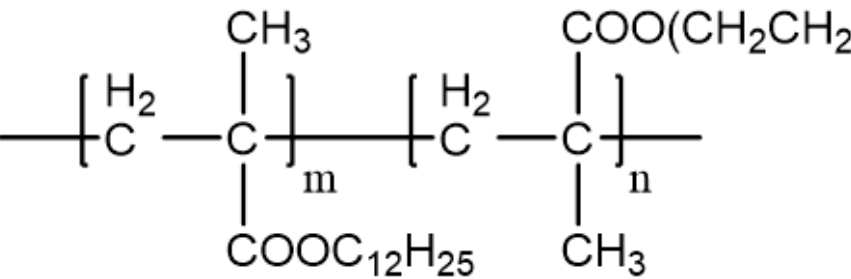
Figure 1. Molecular structure of the dispersant, m/n = 2/1, p = ~12, Mw = 8 × 10 3 g/mol, PDI = 1.43, conversion = 92.1%.